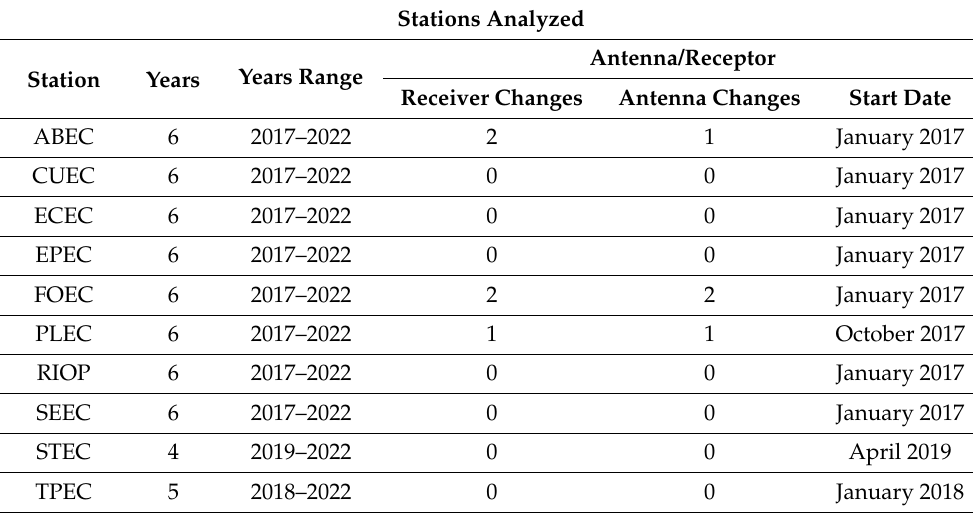
Table 1. Summary of stations analyzed showing the number of data years available, the number of antenna/receiver changes, and the start date of the time